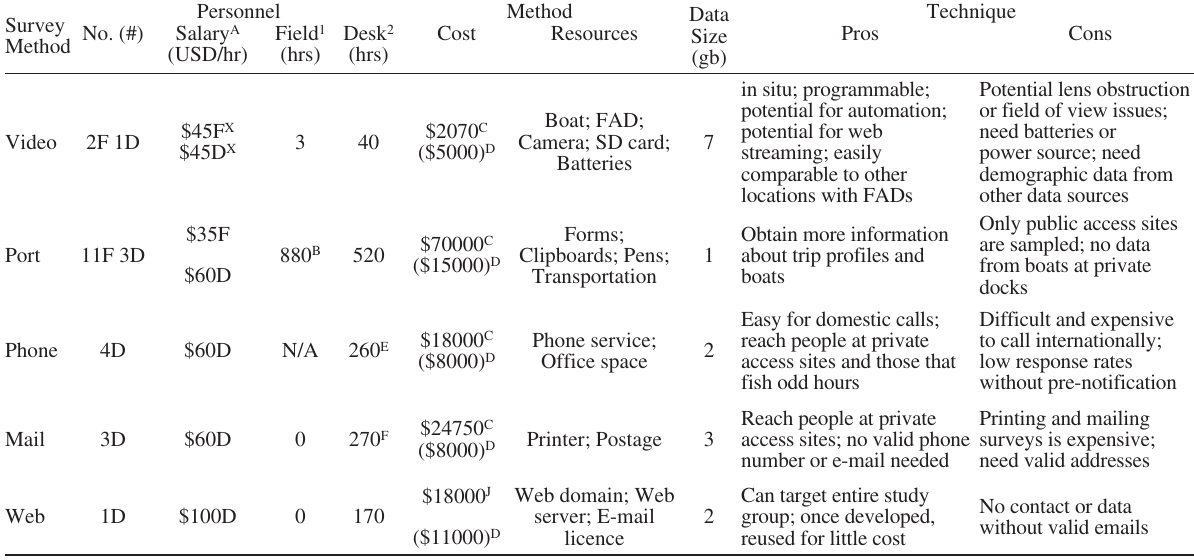
Table 4. – Costs and benefits of video versus traditional survey techniques for one three-week camera deployment in the study region from Loiza to Manati, Puerto Rico; No., number; $F, field; $D, desk. Survey Method